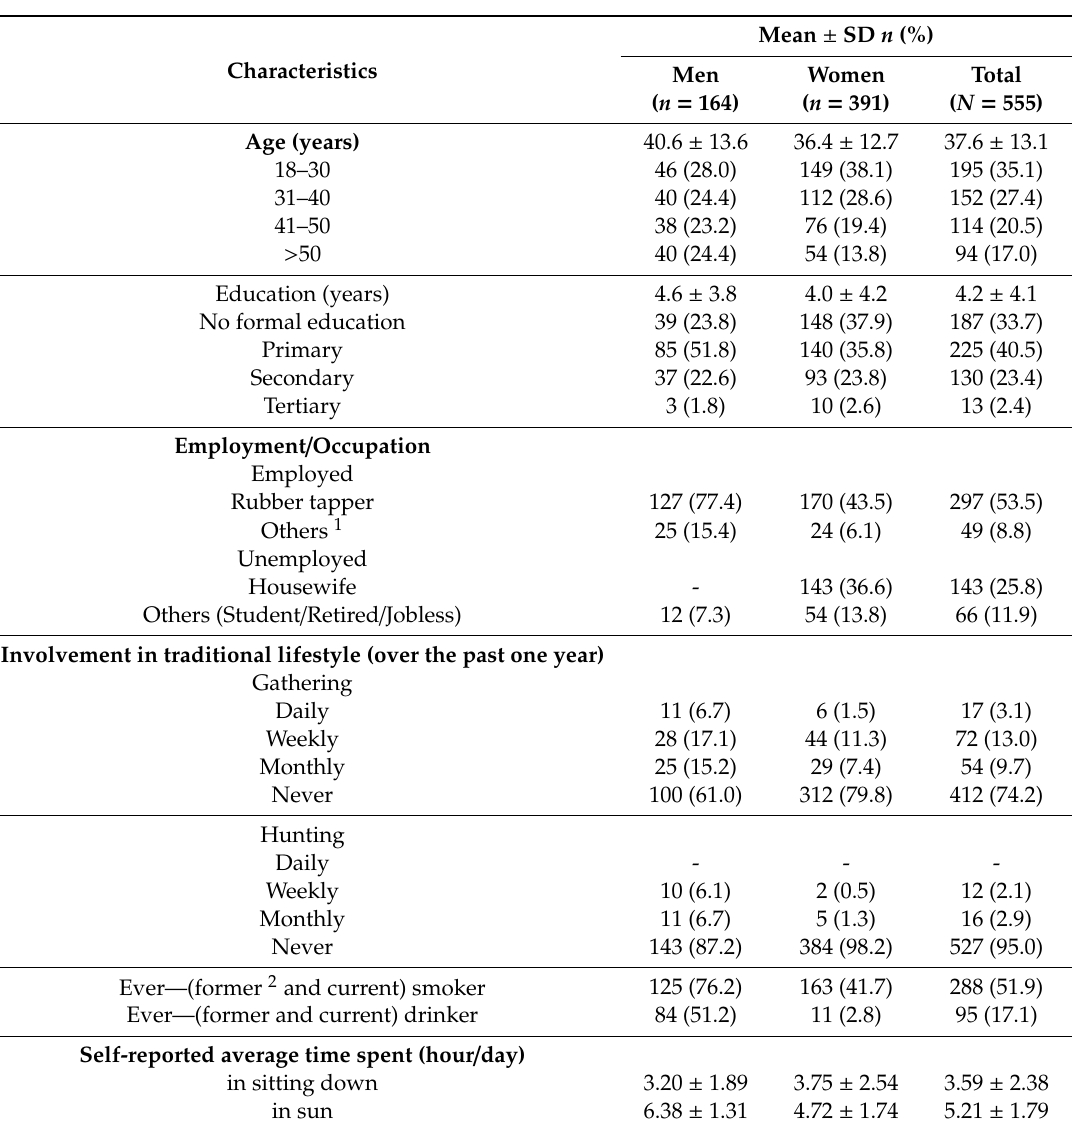
Table 1. Characteristics of respondents by